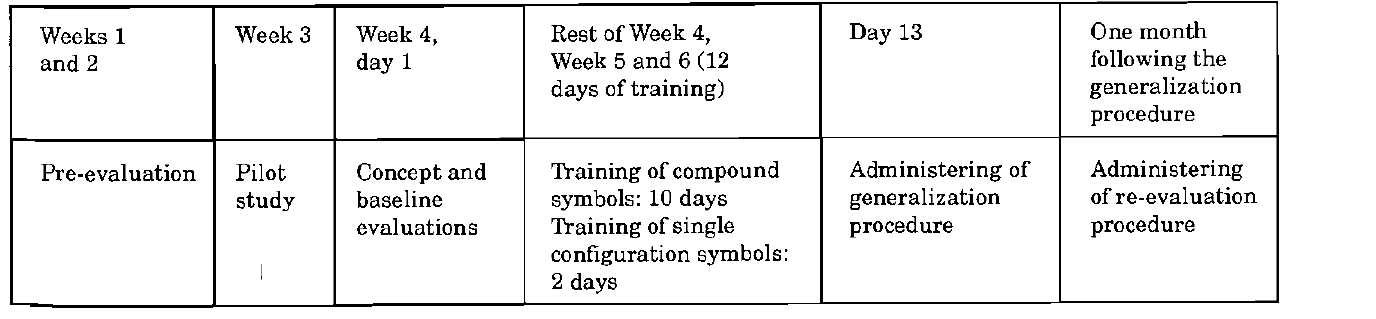
TABLE 4. Weekly outline of the data collection procedures Weeks 1 and